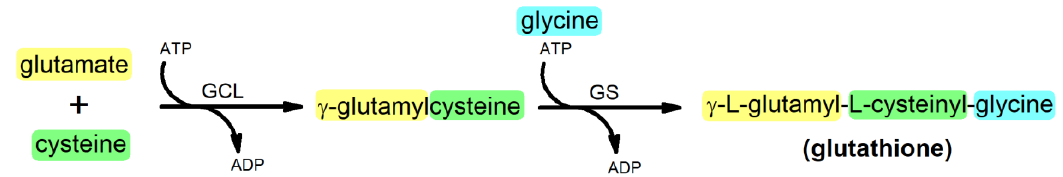
Figure 2. Glutathione synthesis. Three essential amino acids—glutamate, cysteine, and glycine—combine to form the tripeptide glutathione (GSH). At the beginning, cysteine is joined to glutamate through the action of glutamate cysteine ligase (GCL) to produce γ-glutamylcysteine, which proceeds to link with glycine via glutathione synthase (GS) action.